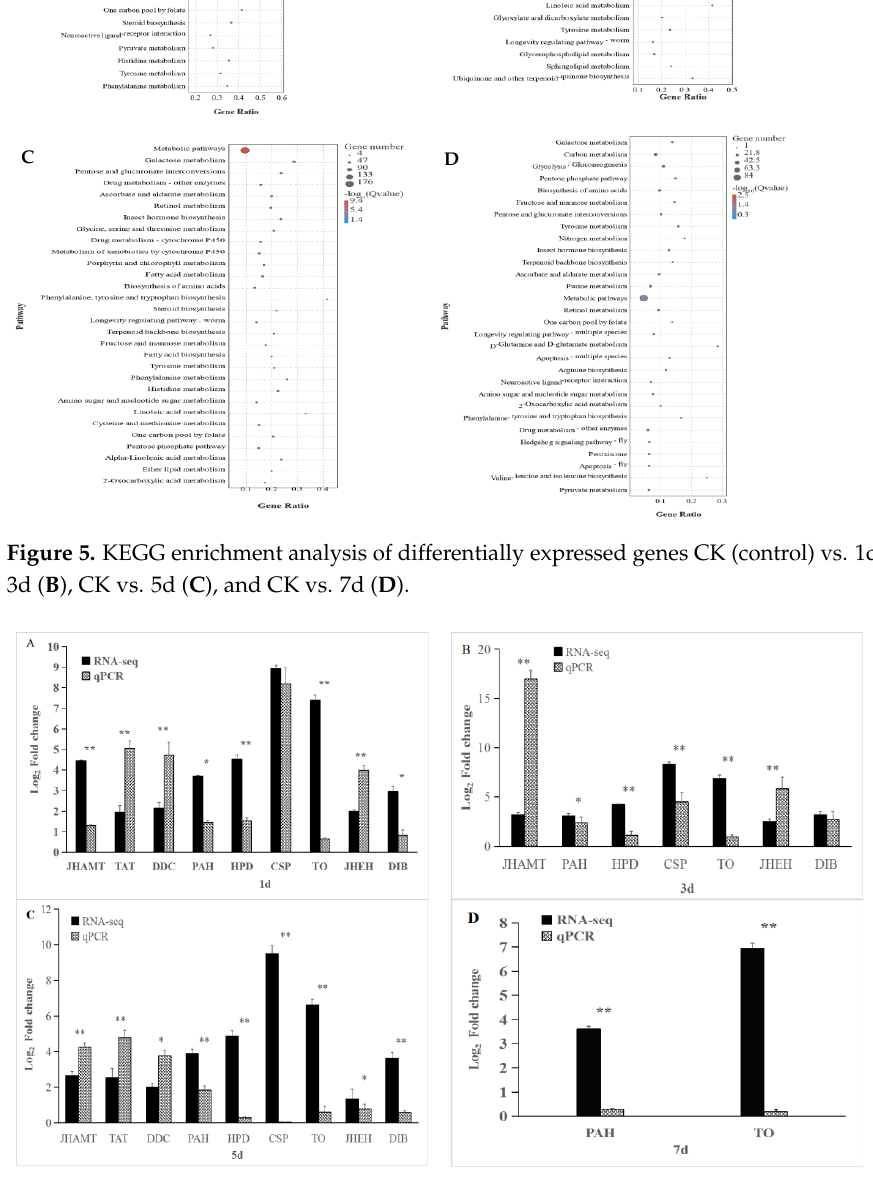
Figure 6. Validation of RNA-seq data by qRT-PCR of the selected differentially expressed genes from the day 1 ( A ), 3 ( B ), 5 ( C ), and 7 ( D ) samples. The gene names are mentioned on the x-axis. The average value of the reference genes (β -actin) was used to normalize transcript levels in each sample. The relative expression level of each gene was calculated by the 2 –∆∆CT method. Error bar represents mean ± SE. * means significant difference at p < 0.05 level; ** means highly significant difference at p < 0.01 level; NS means no significant difference.